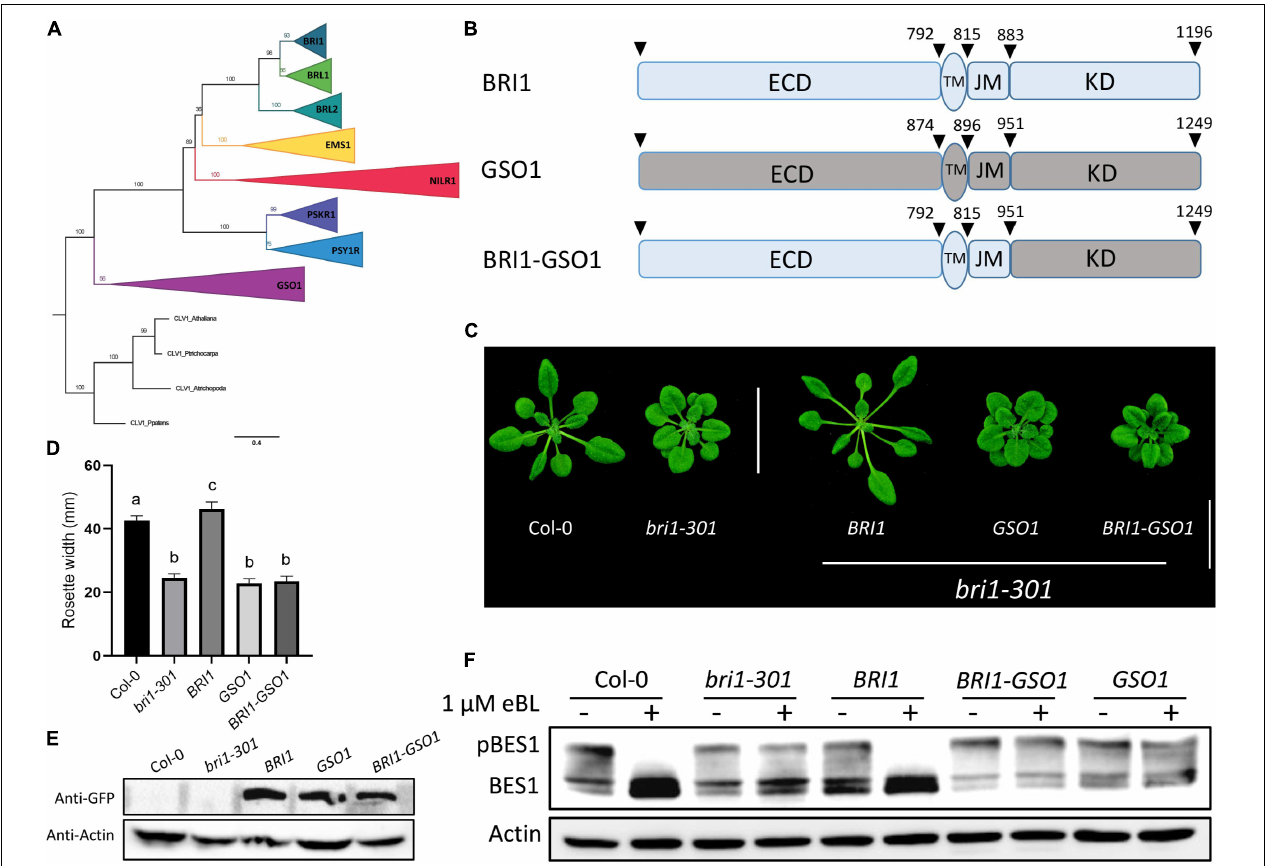
FIGURE 1 | GSO1 and BRI1 ECD fused with GSO1 KD (BRI1-GSO1) could not complement bri1 mutant. (A) The phylogenetic relationship between the BRI1 group members with GSO1 was estimated using maximum likelihood with 1000 bootstrap replicates with CLAVATA1 used as an outgroup. The values on the branches represent the bootstrap values. (B) Schematic representation of BRI1, GSO1, and GSO1 KD fused with BRI1 ECD. The numbers above the receptor represent the starting position of each domain in the receptors. (C) Phenotypes of BRI1, GSO1, and chimeric BRI1-GSO1 receptor in bri1-301 mutants. Scale bar = 2.0 cm. (D) Comparison of rosette width of 4-week-old plants ( n = 15), p < 0.0001, one-way ANOVA with a Tukey’s test. Different letters indicate significant differences. (E) Protein expression level of transgenic lines from panel (C) . (F) BES1 dephosphorylation status. No dephosphorylation of BES1 was observed in GSO1 and chimeric BRI1-GSO1 receptor indicative of no BR signaling. Three independent experiments were performed with similar results.